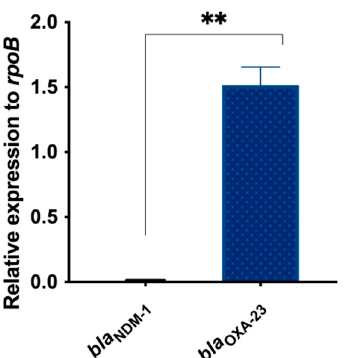
Figure 4. Expression analysis by qRT-PCR of genes coding for β -lactamases ( bla OXA-23 and bla NDM-1 ) in the AMA_NO strain. Fold changes were calculated using Δ Ct analysis. At least three independent samples were used, and four technical replicates were performed from each sample. Student’s t -test analysis was performed using GraphPad Prism (GraphPad software, San Diego, CA, USA). **: A p-value < 0.01 was considered statistically significant. Data are presented as the mean ± SD.